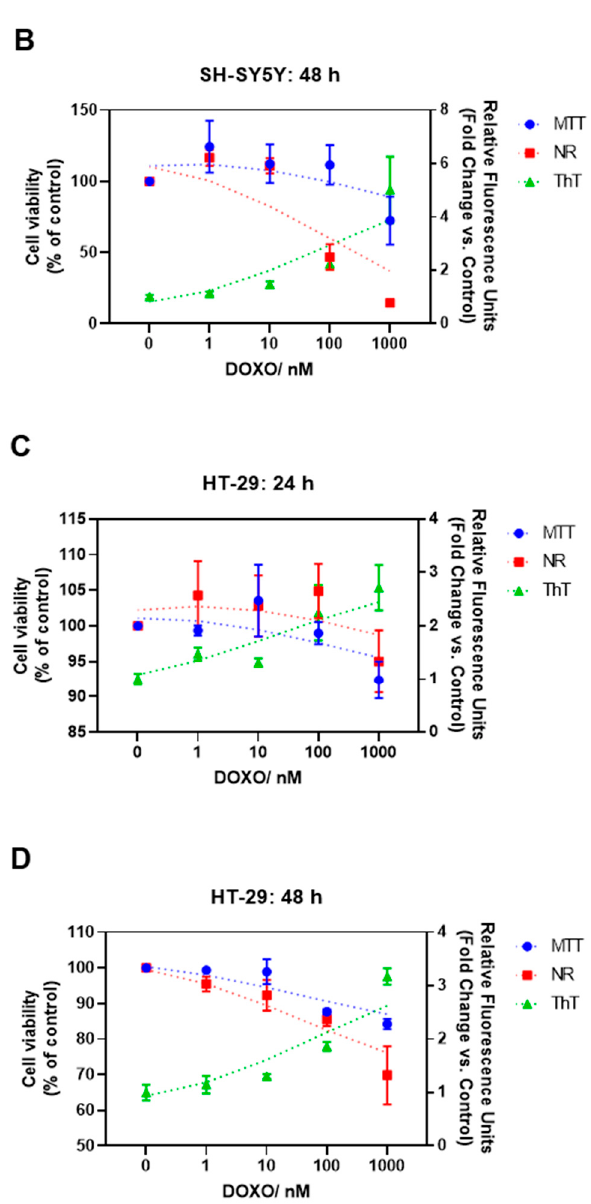
Figure 10. Relationship between MTT, NR, and ThT results obtained in two different cell lines, SH-SY5Y neuroblastoma ( A , B ) and HT-29 colon cancer cells ( C , D ) treated with DOXO for 24 and 48 h, respectively.